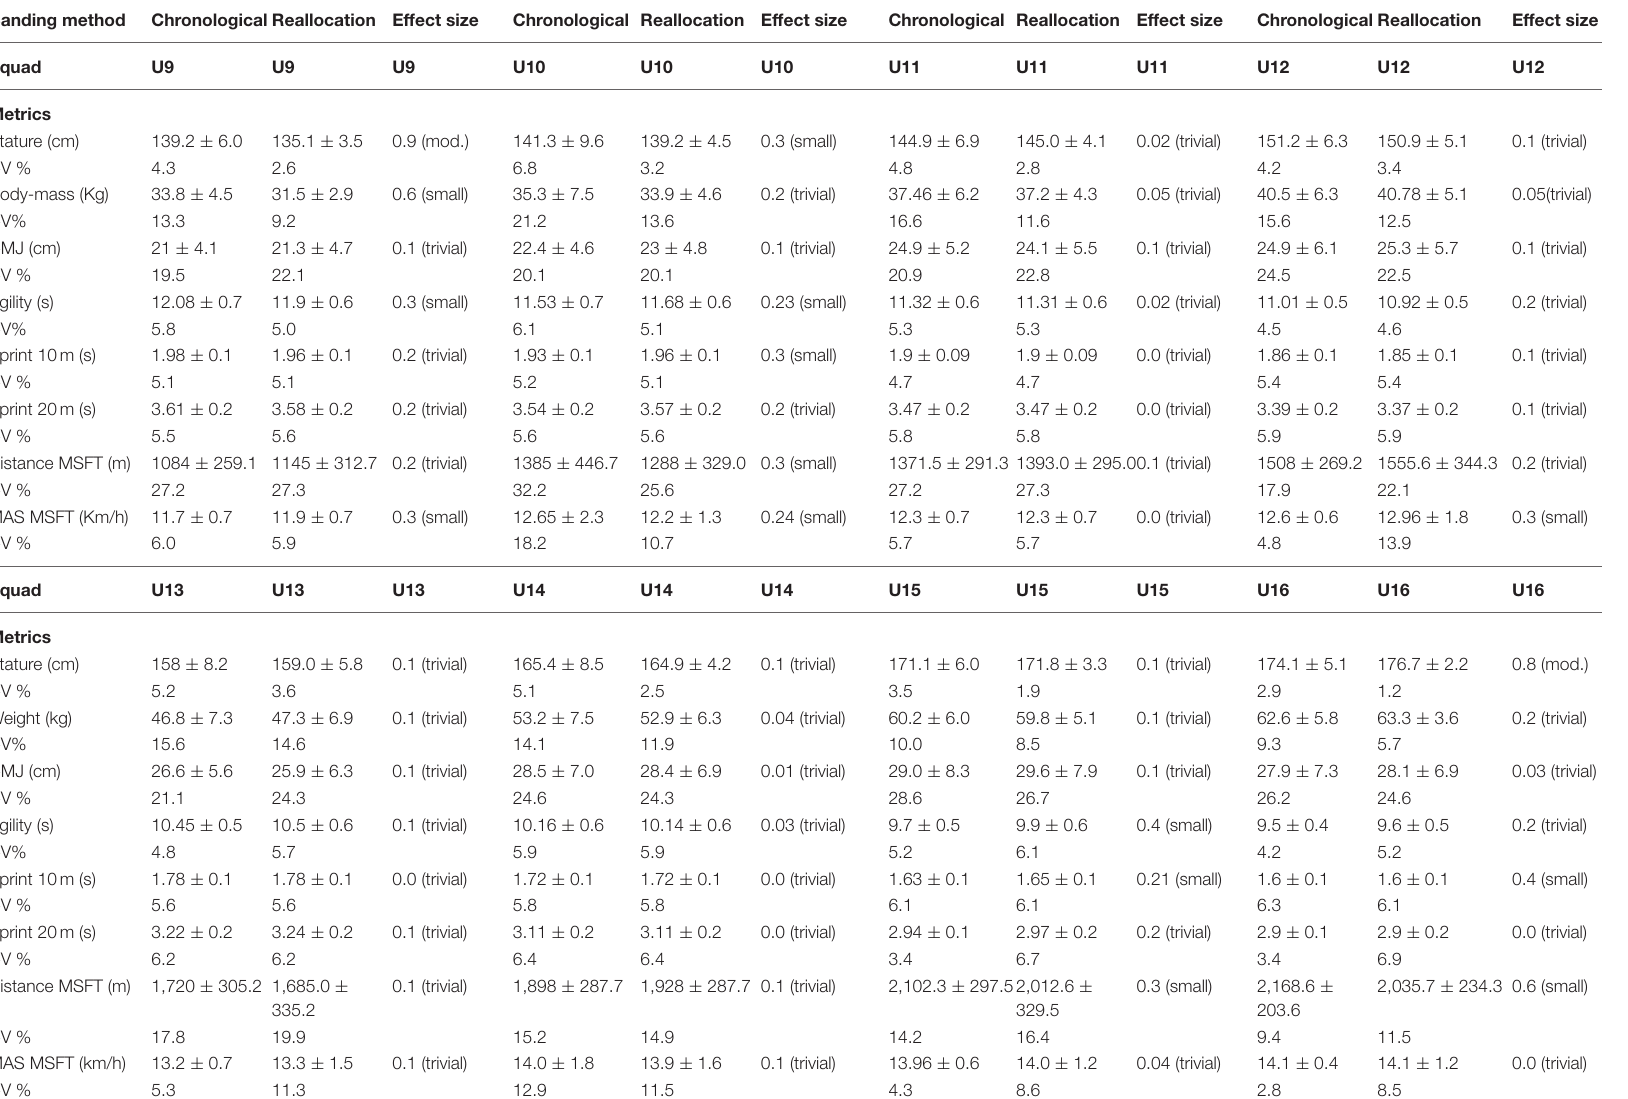
TABLE 6 | Summary table of mean ± SD and effect sizes for anthropometrical and physical characteristics of UK academy soccer players (U9–U16) according to traditional chronologically ordered and the proposed reallocation method. Banding